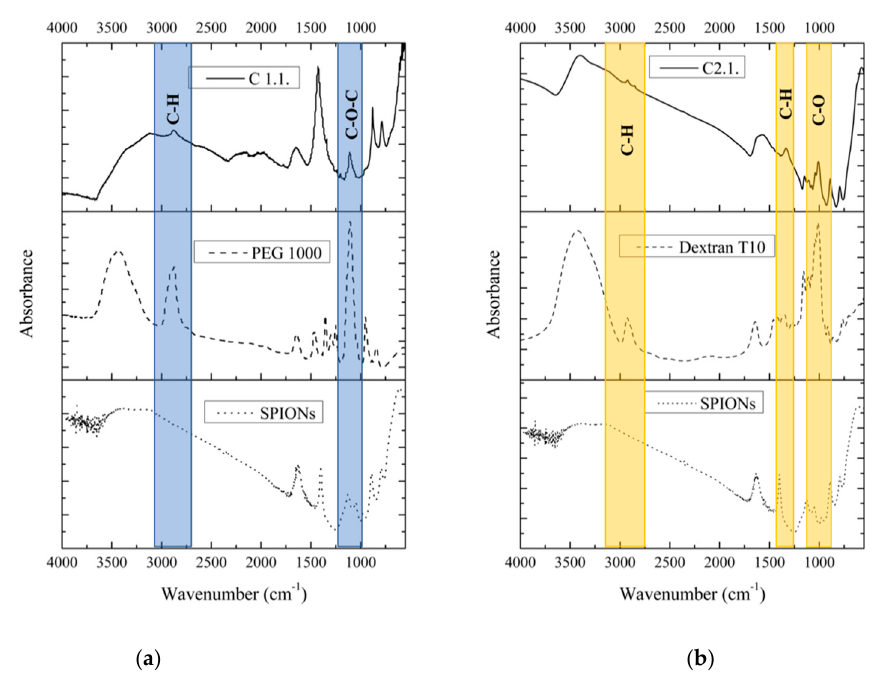
Figure 3. FTIR spectra of coated SPIONs: ( a ) sample C 1.1 and ( b ) C